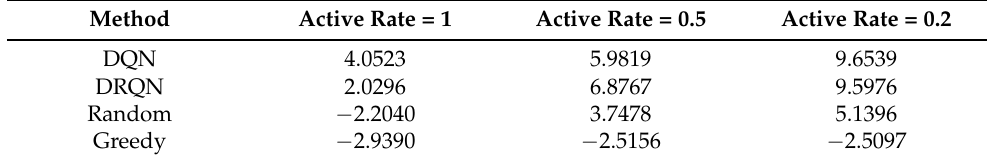
Table 6. The reward after 200,000 steps under different active rates ( M = 3, N = 6, L =